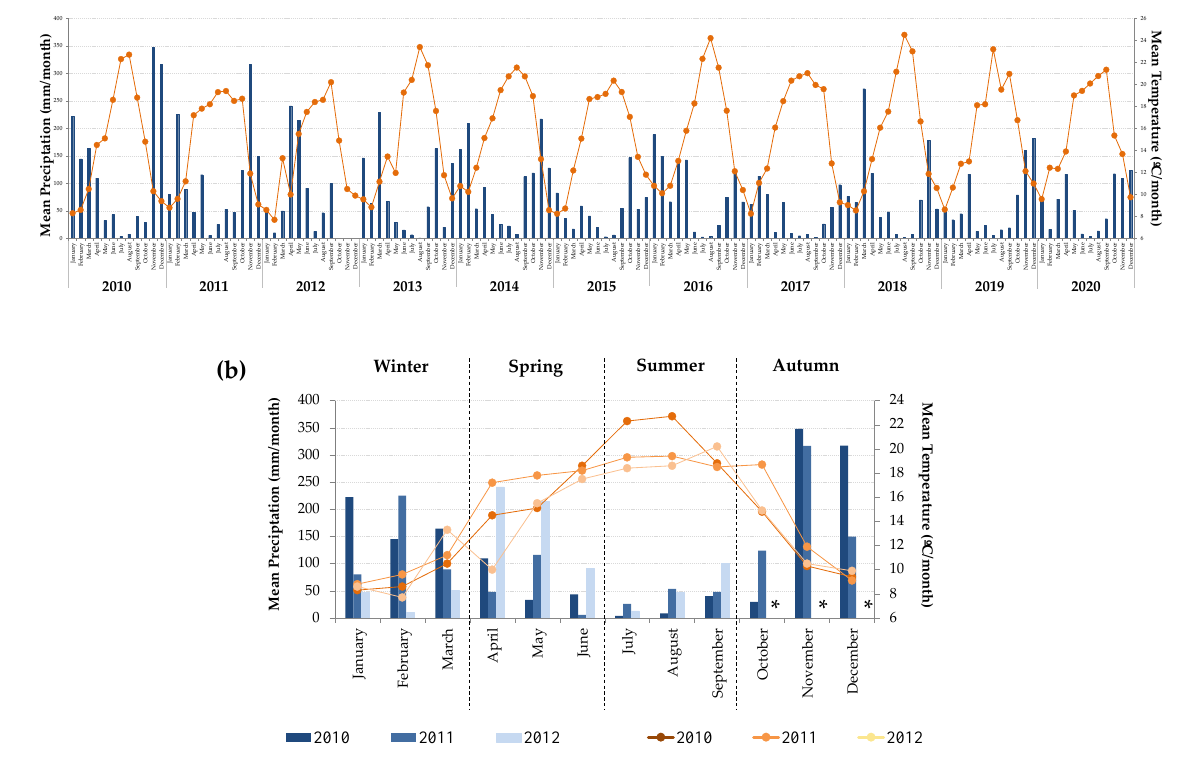
Figure 2. Meteorological data available for Bairrada Appellation, expressed as mean precipitation (blue colors) and temperature (orange colors): ( a ) data from the last decade (2010–2020) and ( b ) zoom of the three harvests under study (2010–2012). * Precipitation data were not available at the meteorological station from October to December of 2012